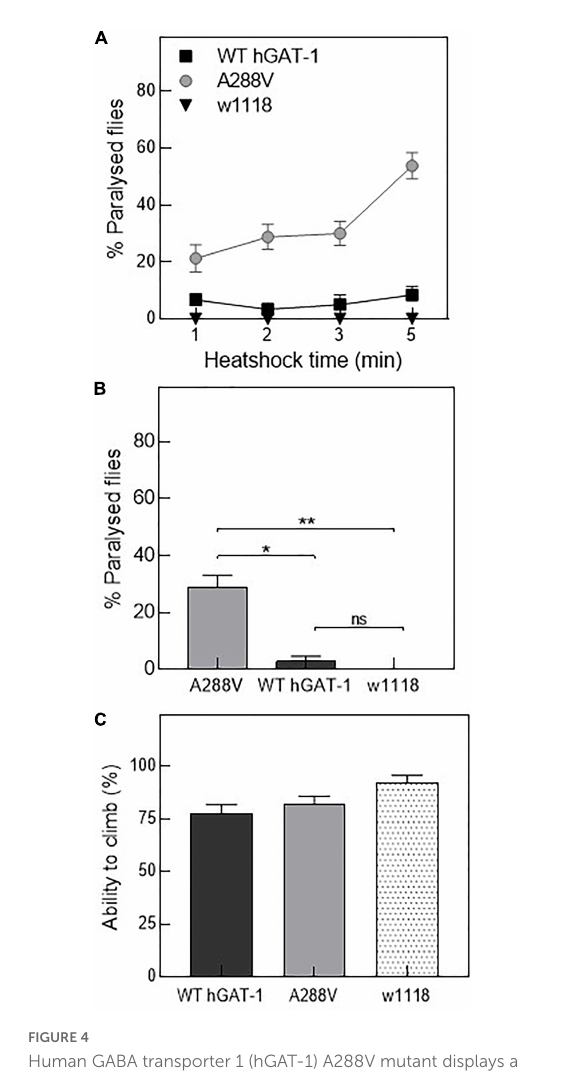
FIGURE4 Human GABA transporter 1 (hGAT-1) A288V mutant displays a heat-induced seizure phenotype. (A,B) Seizure susceptibility in different genotypes as indicated by percentage of flies displaying the seizure repertoire after heat induction. (A) Three to five days old 10 male flies of genotype w1118;ALRM GAL4; UAS-YFP-hGAT-1 WT; and ALRM-GAL4; UAS-YFP-hGAT1-A288V were kept in a water-bath for 1, 2, 3, and 5 min and seizure activity was studied during the said period ( n : 6). (B) Shows percent paralyzed flies, following 2 min heat inductions ( n : 6). The statistical comparison was done by analysis of variance followed by Dunn’s post-hoc test ( p -value for WT compared to A288V (*) = 0.0045, p -value for w1118 compared to A288V (**) = 0.0003). (C) Climbing activity of flies was studied by assessing the ability of flies to climb 70% of 18 cm long climbing chamber in 30 s. No significant difference was observed. Means ± S.E.M. are indicated, from at least six